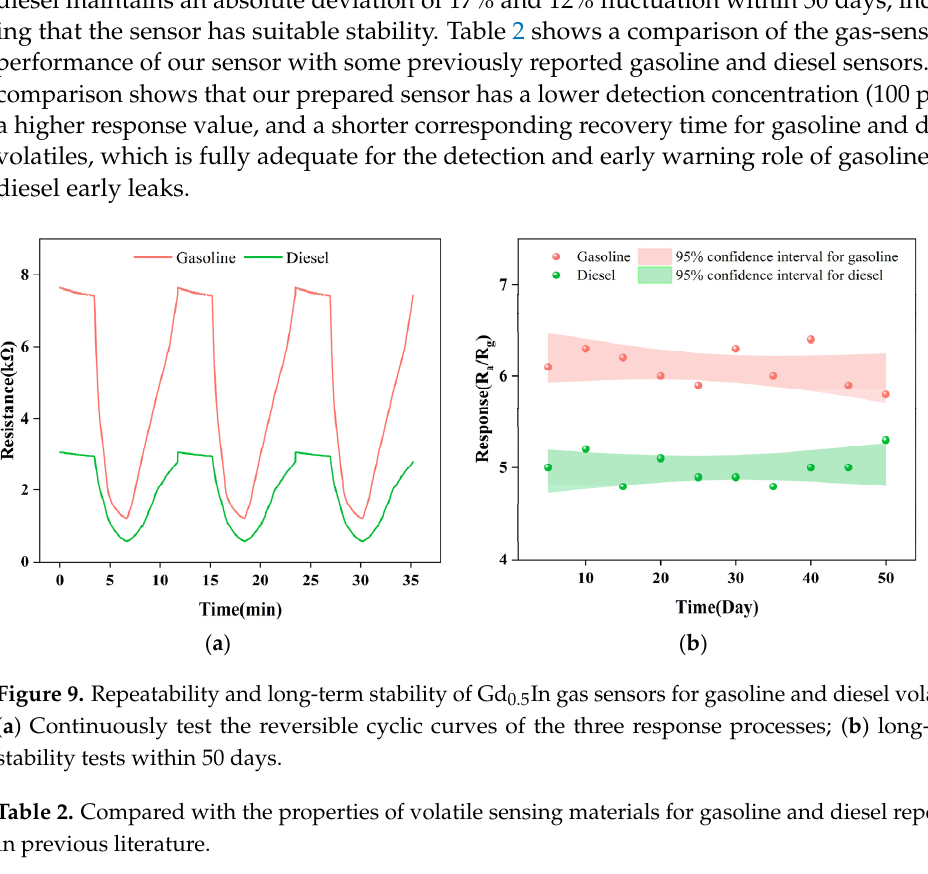
Figure 8. Response of Gd 0 . 5 In to 100 ppm of different test gases at 250 ° C .